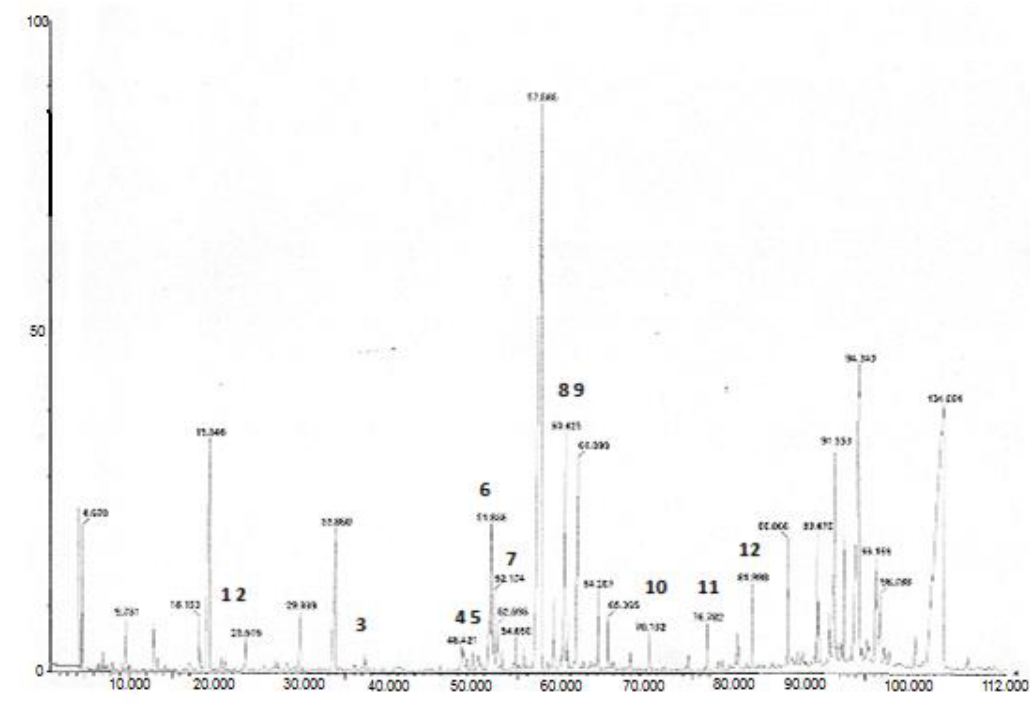
Figure 2. Typical GC/MS chromatograph of O. vulgare L. where: 1, cinnamic acid; 2, homogentisic acid; 3, p -hydroxybenzoic acid; 4, vanillic acid; 5, gentisic acid; 6, p -coumaric acid; 7, protocatechuic acid; 8, p -coumaric acid; 9, hydroxycaffeic acid; 10, gallic acid; 11, caffeic acid; 12, 3-nitro-phthalic